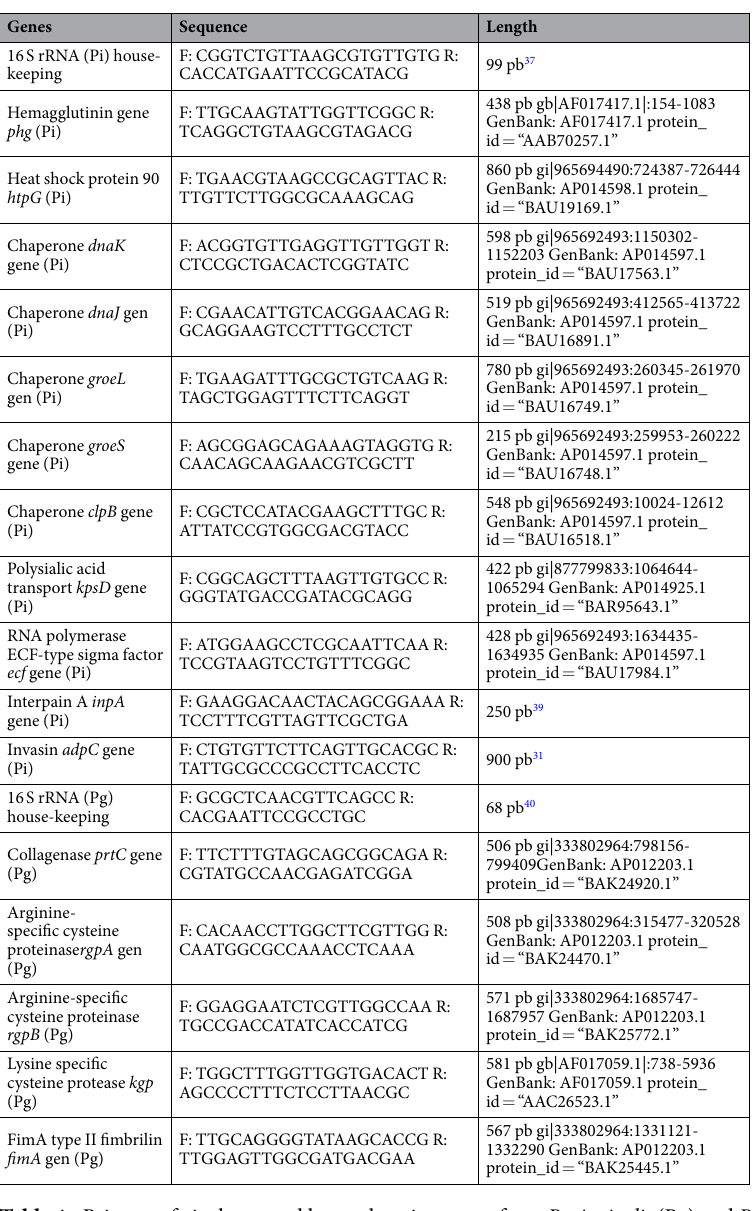
Table 4. Primers of virulence and house-keeping genes from P . gingivalis (Pg) and P . intermedia